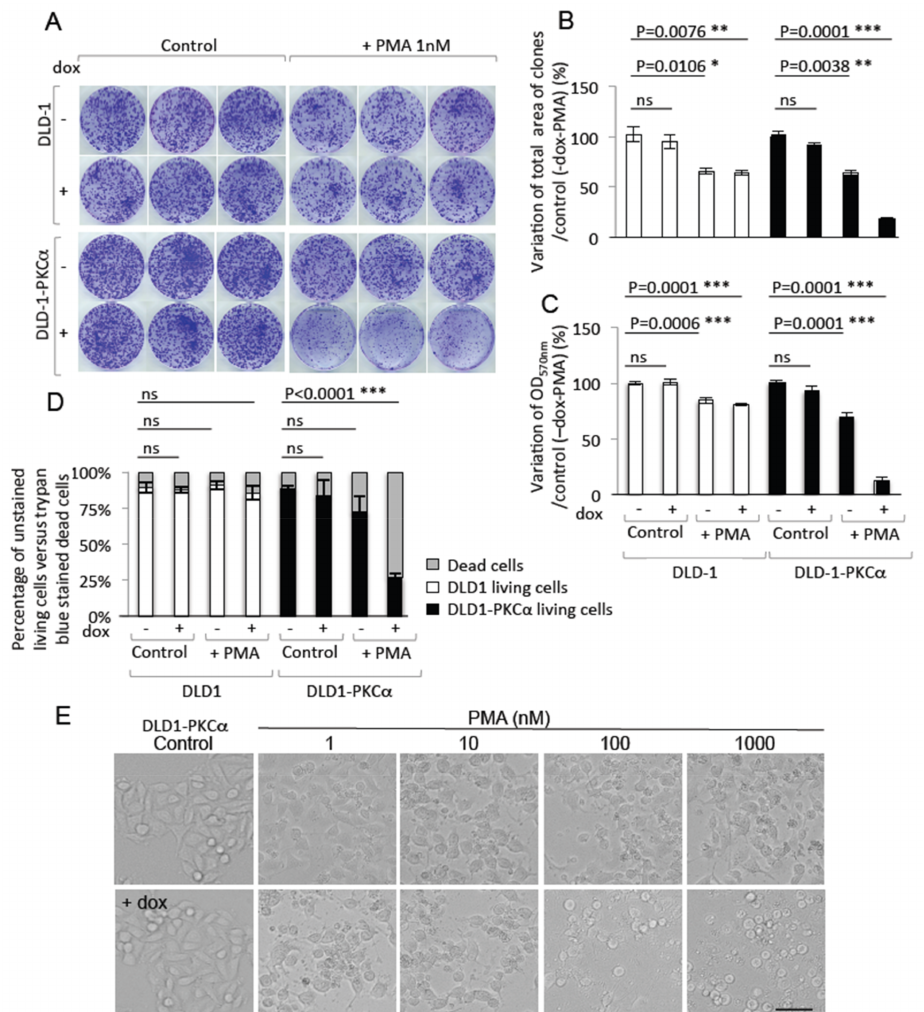
Figure 6. PKC α activity induces DLD-1 CRC cell death. ( A ) Crystal violet assays in DLD-1 control cells and DLD-1-PKC α cells incubated or not with 1 µ M doxycycline and / or 1 nM PMA for 10 days. Quantification of the variations ( B ) of the total area occupied by the clones, and ( C ) of the OD 570 nm values (compared with the control condition without doxycycline and PMA) shows that increasing PKC α function in DLD-1-PKC α cells (doxycycline + PMA) leads to a reduction in clone formation due to cell growth inhibition. ( D ) Quantification of the percentage of trypan blue-positive DLD-1 and DLD-1-PKC α cells (i.e., dead cells; in grey) and –negative living cells (white: DLD-1 cells; black: DLD-1-PKC α cells) after exposure to 1 µ M doxycycline and / or 1nM PMA for 10 days demonstrates that increasing PKC α function in DLD-1-PKC α cells (doxycycline + PMA) strongly induces cell death. ( E ) Phase-contrast images of DLD-1-PKC α cells incubated with increasing concentrations of PMA without or with 1 µ M doxycycline for 24 h show that DLD-1-PKC α cell death is PMA dose-dependent. Scale bar: 20 µ m. * p ≤ 0.05, ** p ≤ 0.01, *** p ≤ 0.001, ns: p >